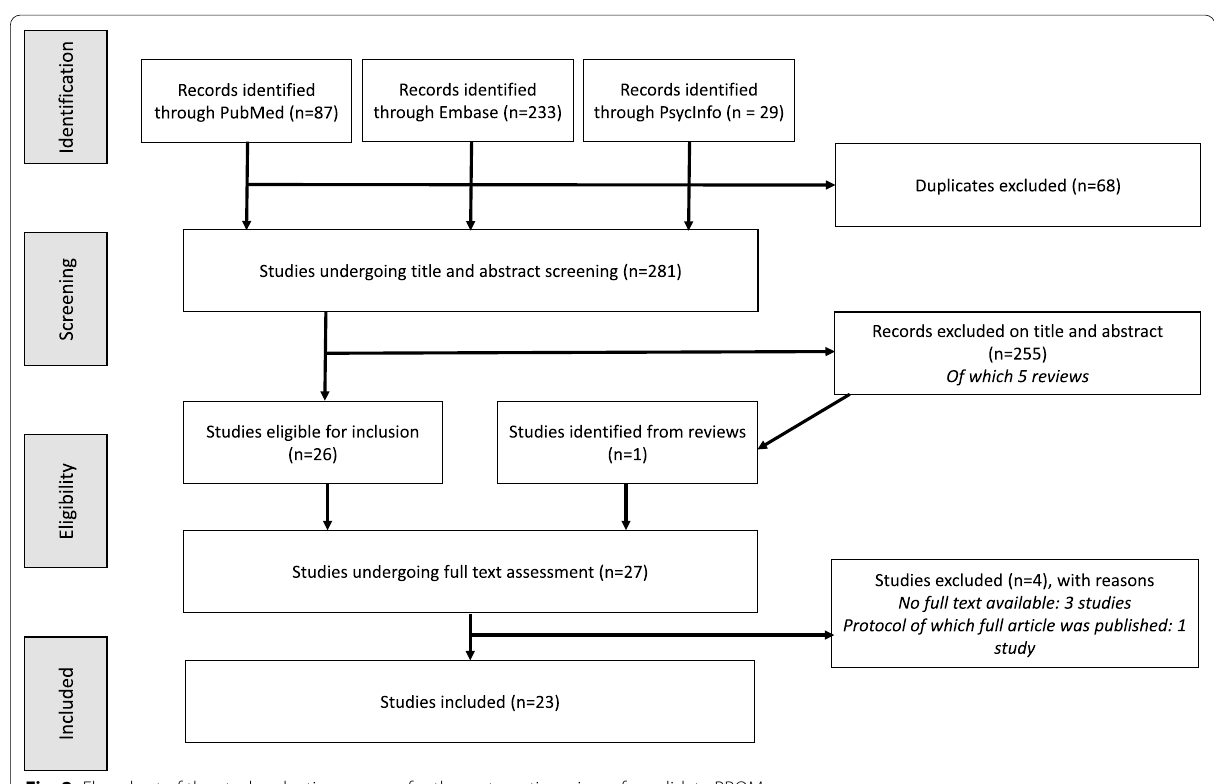
Fig. 2 Flowchart of the study selection process for the systematic review of candidate